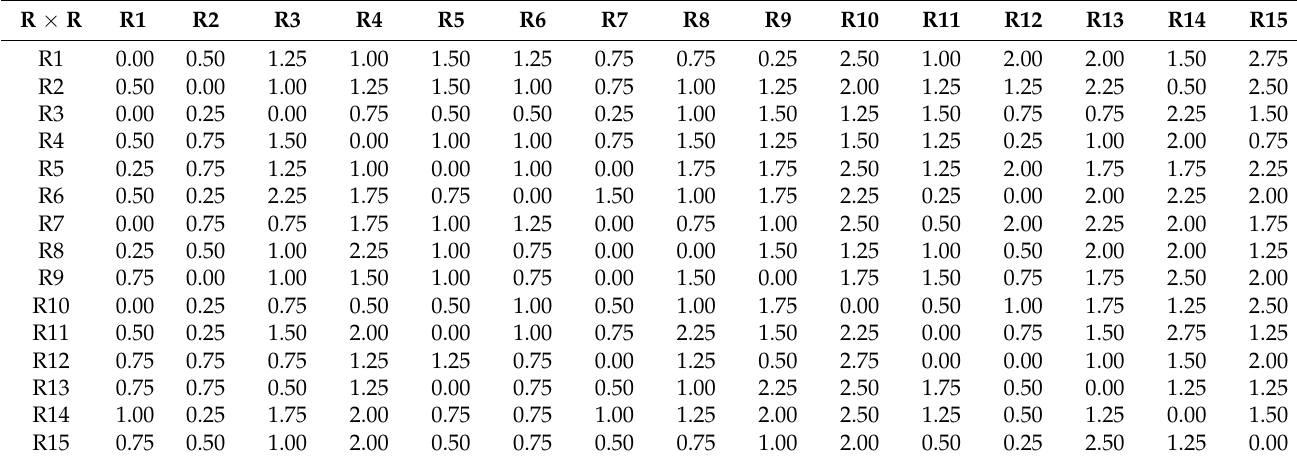
Table 5. REFs correlation matrix